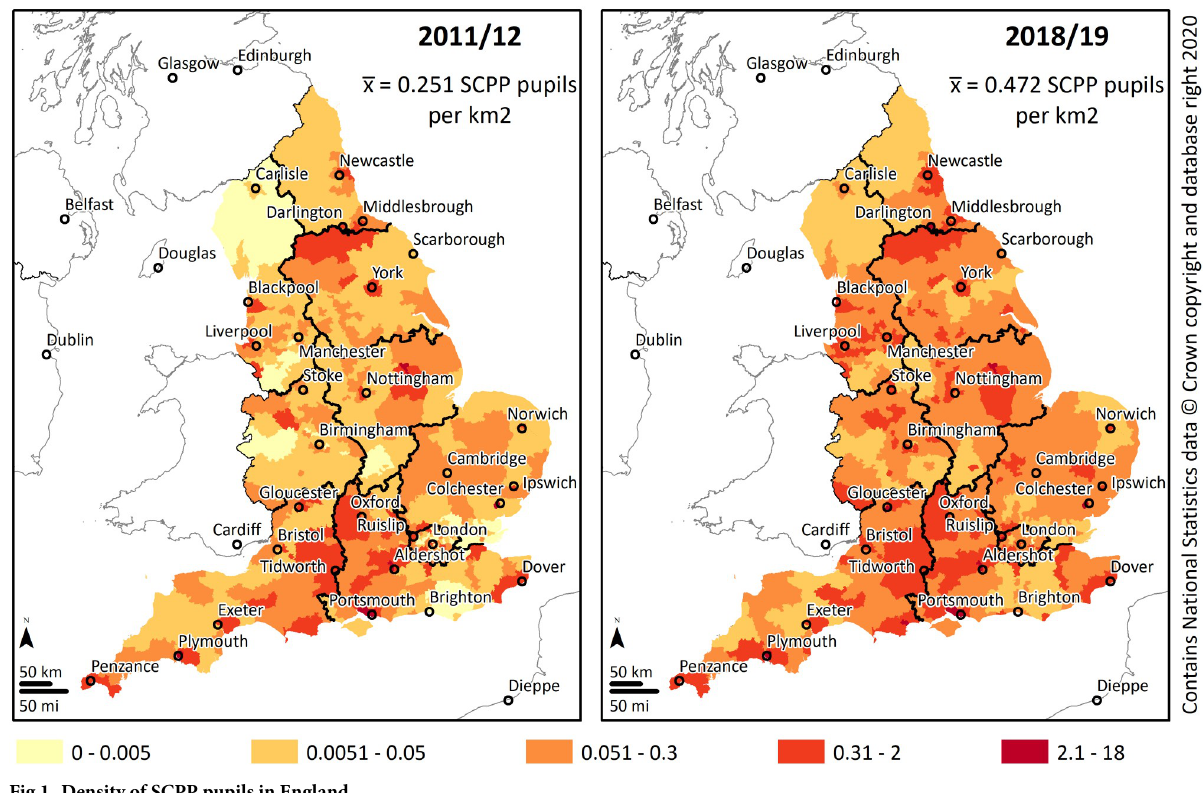
Fig 1. Density of SCPP pupils in England.